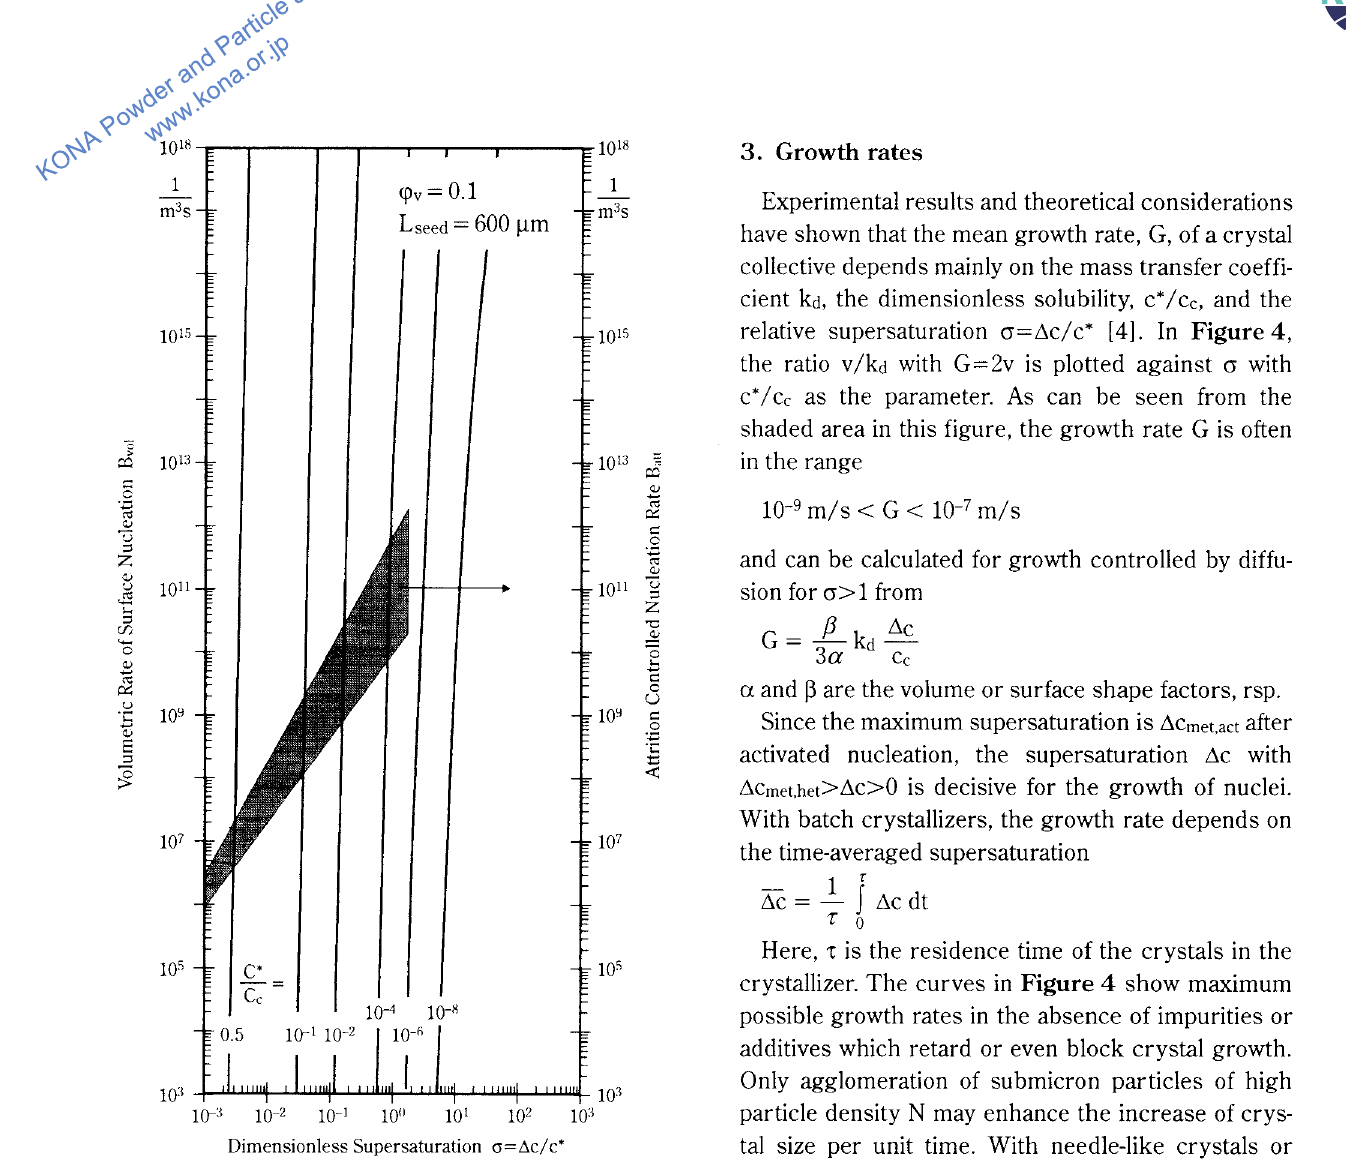
Volumetric nucleation rate against the dimensionless super· saturation for activated and attrition-controlled nucleation